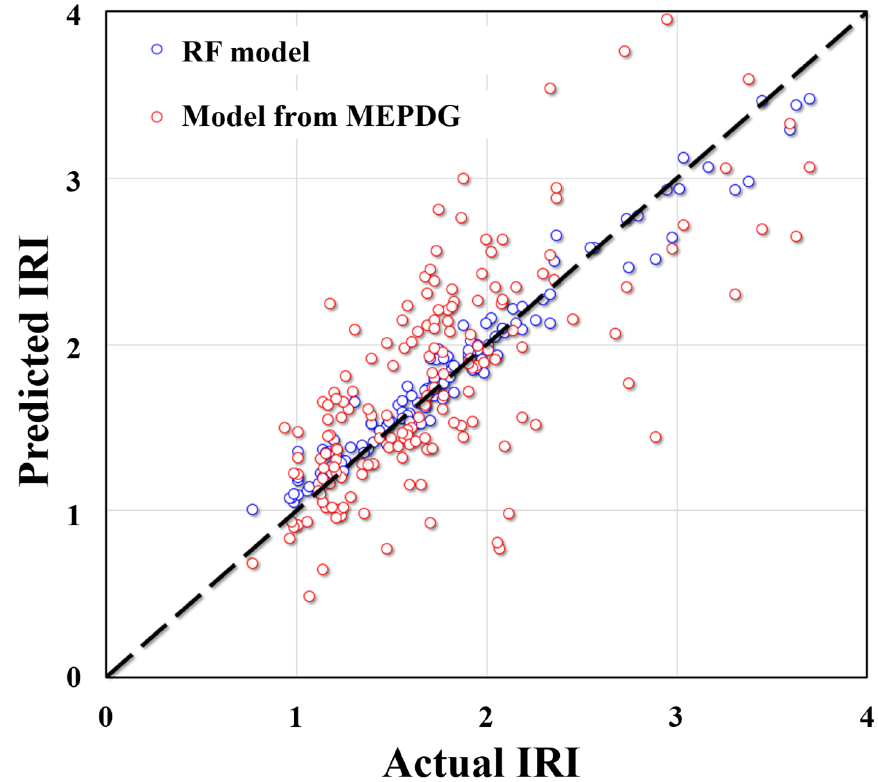
Figure 8. Comparison between the RF model and model from MEPDG.